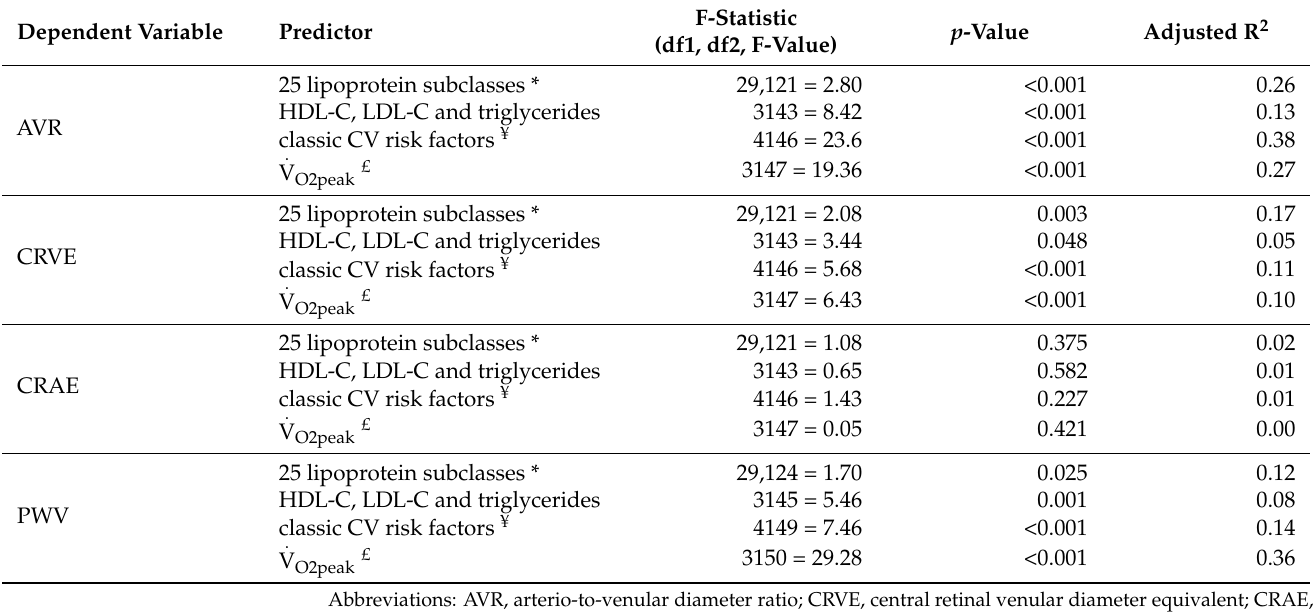
Table 4. Linear regression